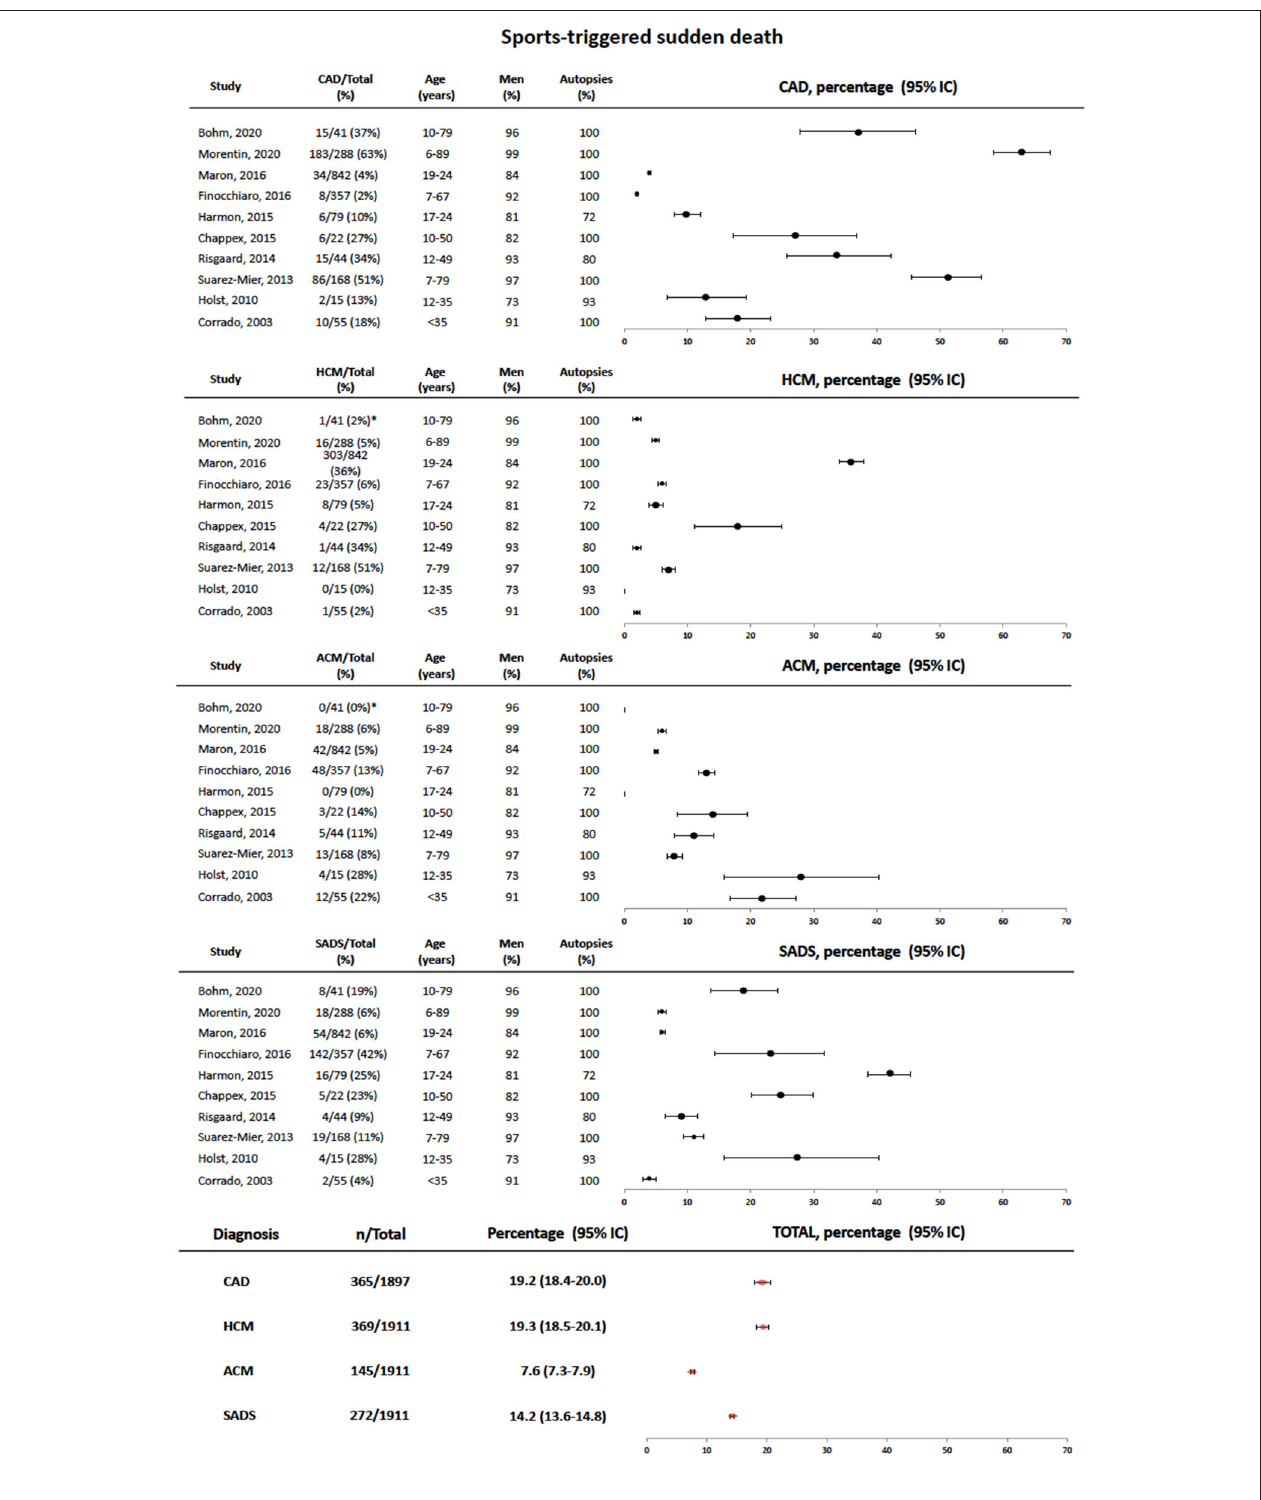
FIGURE 3 | Forest plot showing pooled data of the causes of sports-triggered sudden cardiac death in different series referenced in the text. At the bottom, total estimates are provided for each diagnosis. SCD, sudden cardiac death; CAD, coronary artery disease; SADS, sudden arrhythmic death syndrome; HCM, hypertrophic cardiomyopathy; ACM, arrhythmogenic cardiomyopathy. *The causes of death can be only retrieved form the 41 cases of sports-related sudden death cases with autopsy.